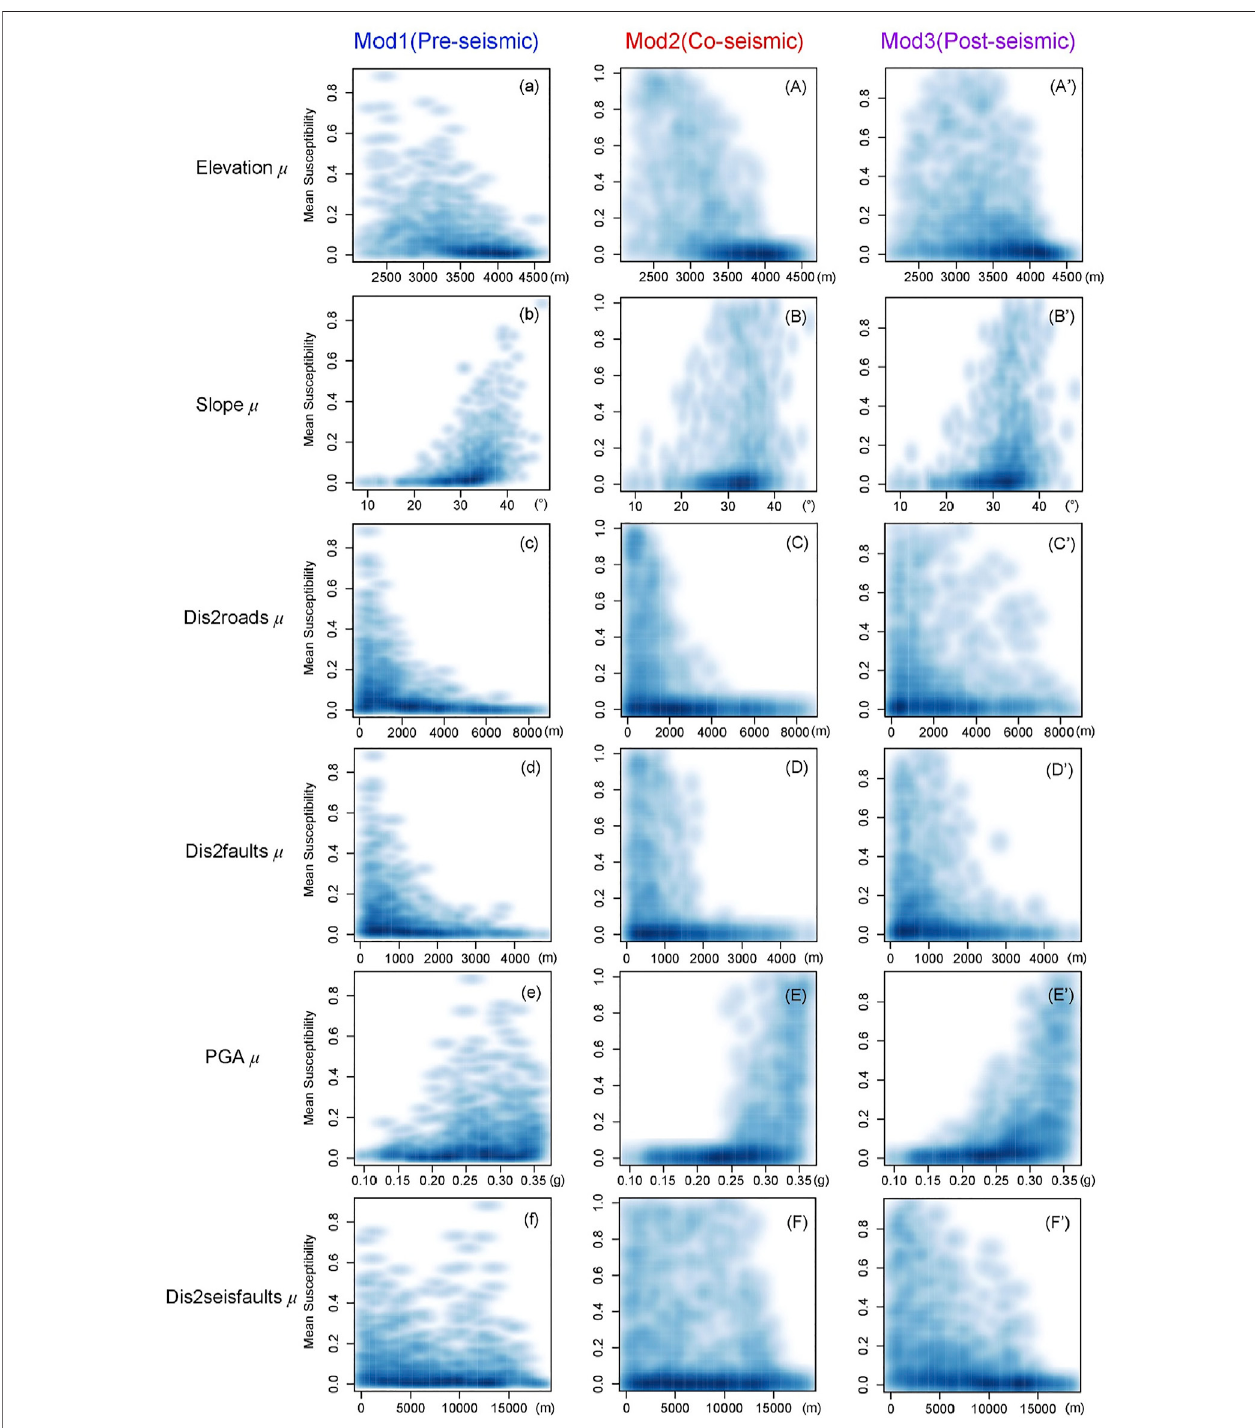
FIGURE 11 | Two-dimensional (kernel density) smoothed scatter plots showing the bivariate relationship between the mean susceptibility and each covariate for Mod1 (left panel), Mod2 (middle panel), and Mod3 (right panel).